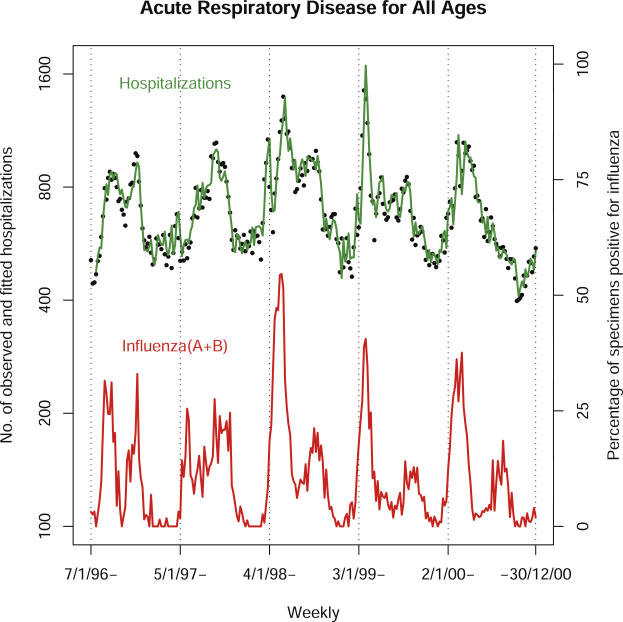
Weekly number of observed and fitted hospitalizations, and percentage of specimens positive for influenza